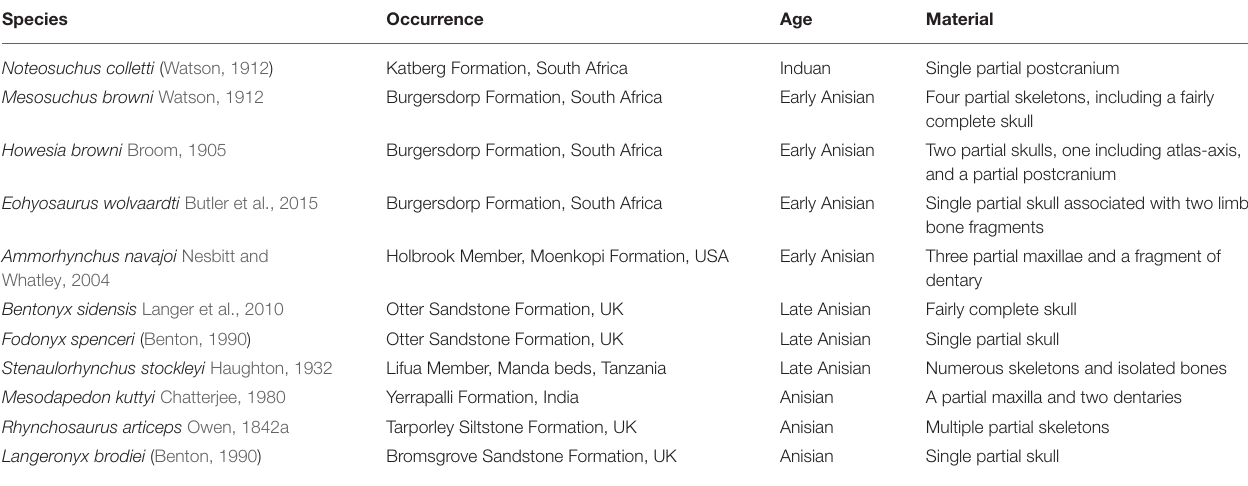
TABLE 1 | List of known Induan-Anisian rhynchosaur nominal species and their temporal and geographic occurrence ordered by chronostratigraphic age.